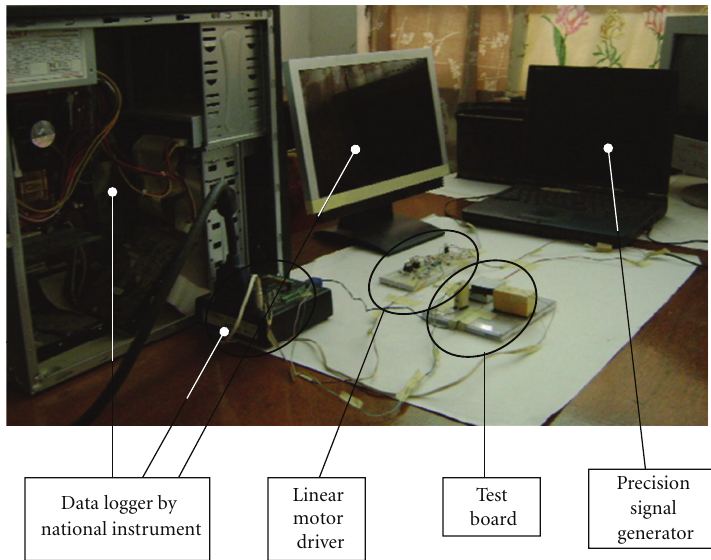
Figure 22: The frequency loss determination equipment.